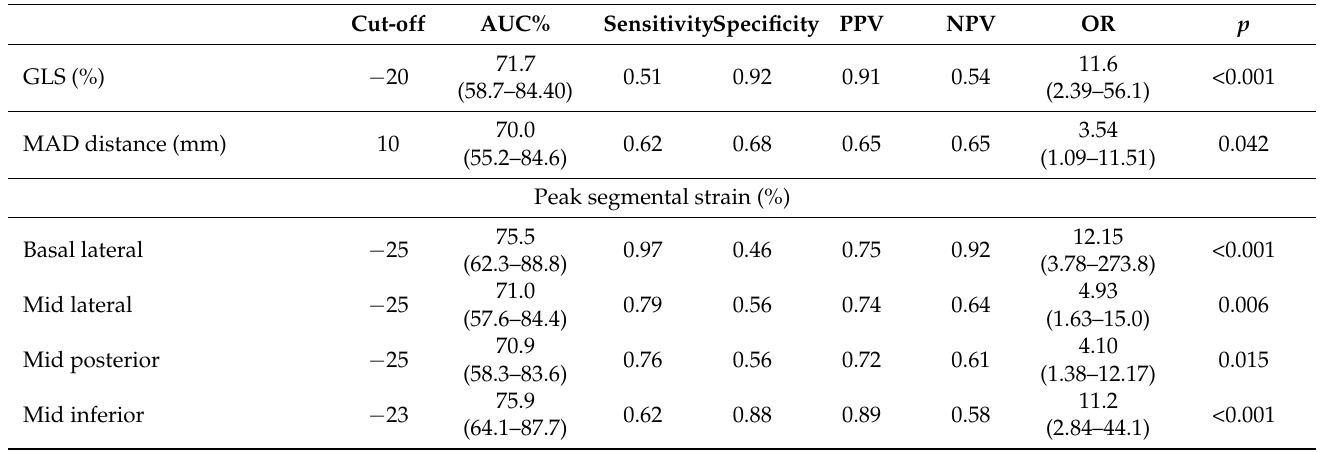
Figure 9. The example of the “Bull’s-eye” representation (obtained from long-axis, 2- and 4-chamber apical views) of regional strains in the MAD+ patient. Panel ( A ) presents the basal lateral seg- ment with augmented values of longitudinal strain and MWI (marked segment). Panel ( B ) present basal septal segment with lower values of longitudinal strain and myocardial work index (marked segment). Table 5. Cut-off values and prognostic accuracy of the analyzed parameters as predictors of the primary